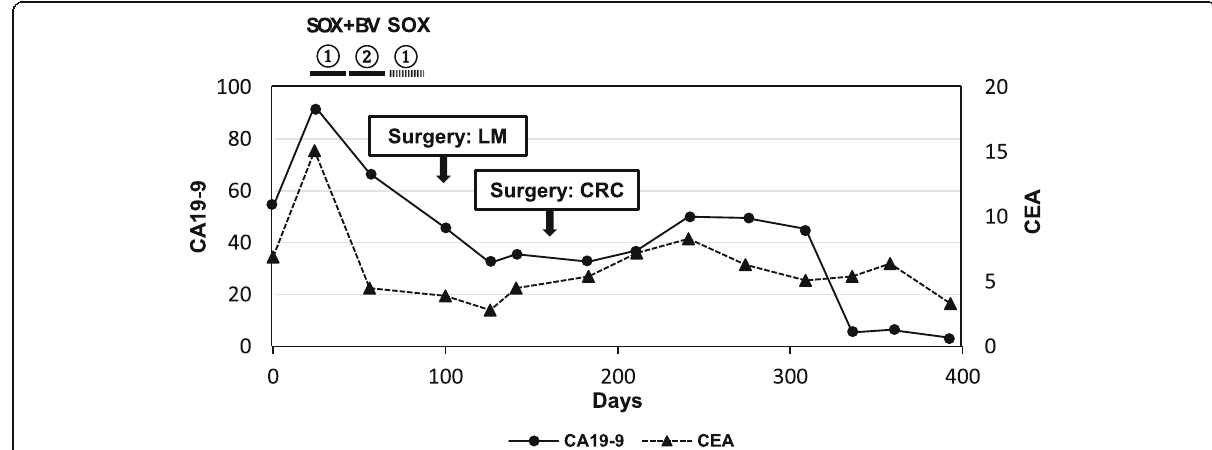
Fig. 5 The clinical course of the patient and transition of tumor marker levels. CA 19-9 and CEA levels decreased after initiation of systemic neoadjuvant chemotherapy. CA 19-9, carbohydrate antigen 19-9; CEA, carcinoembryonic